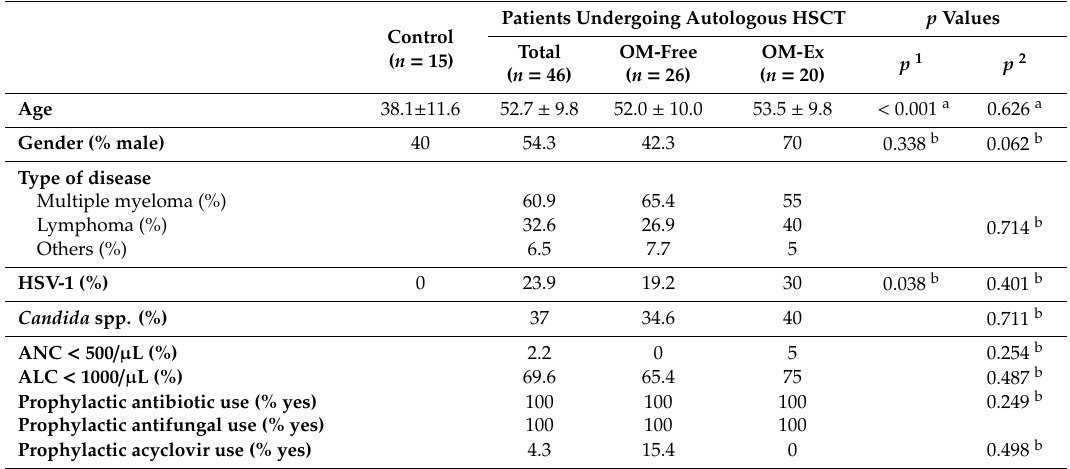
Table 1. Subject characteristics at baseline and their associations with oral mucositis.